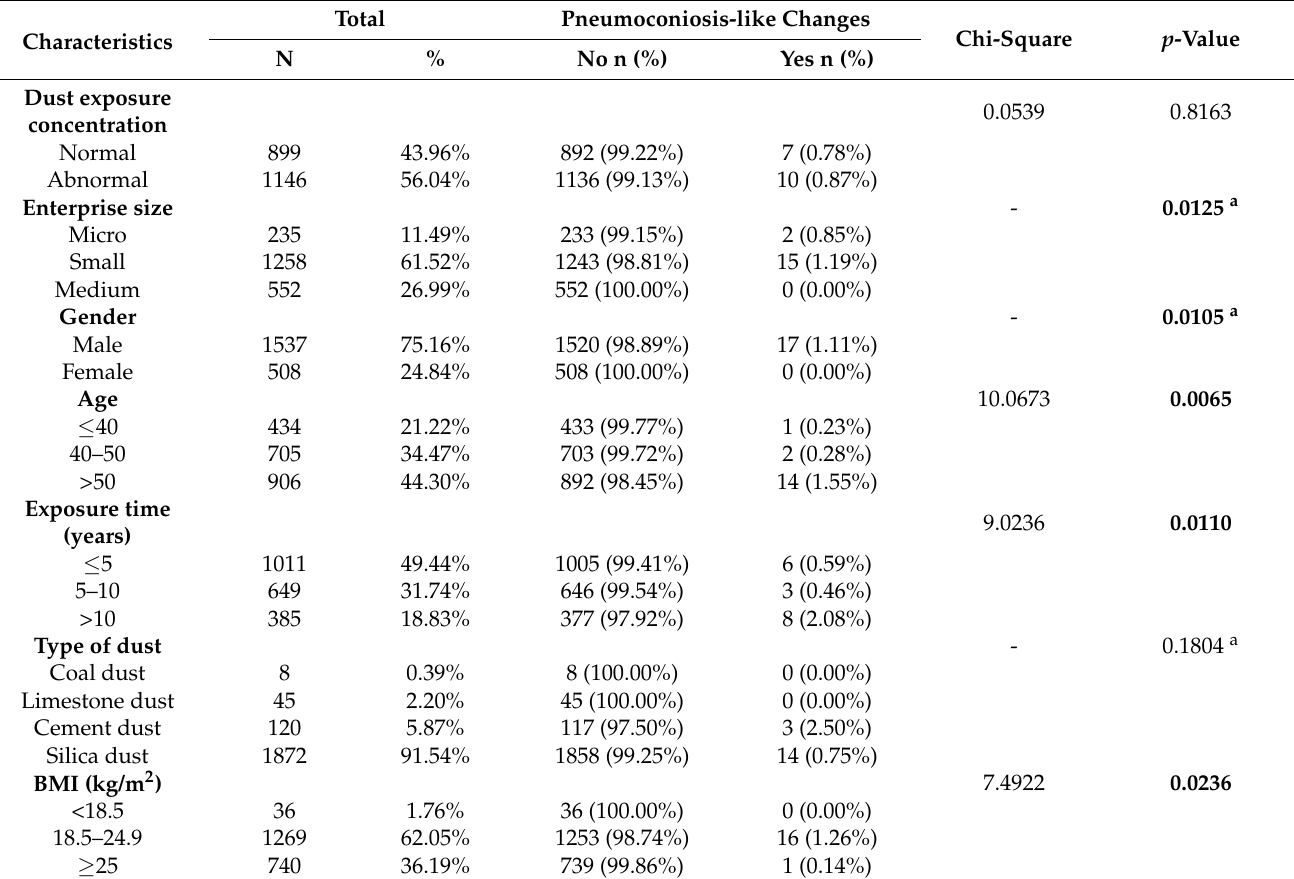
Table 1. Factors related to pneumoconiosis-like